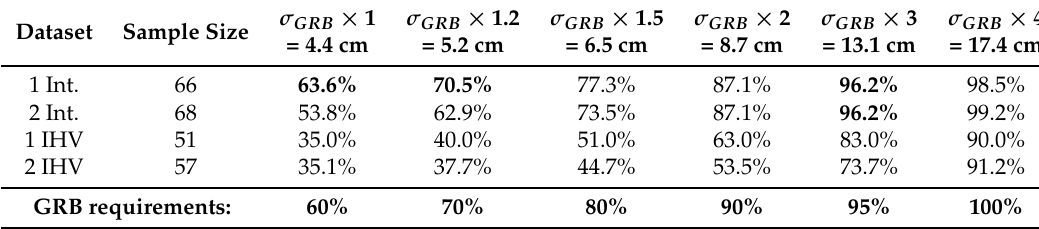
Figure 8. Visualization of the location predictions (green points) on a manhole cover for the different trained VGG-16 networks ( a – d ). The mean error and 95% confidence interval circles are shown in blue and red, respectively. The manhole cover in the background is up to scale and gives a sign of reference on how accurate each network performs. Table 7. The distribution results per accuracy interval for the different VGG-16 networks. Results conforming to the GRB requirements are shown in